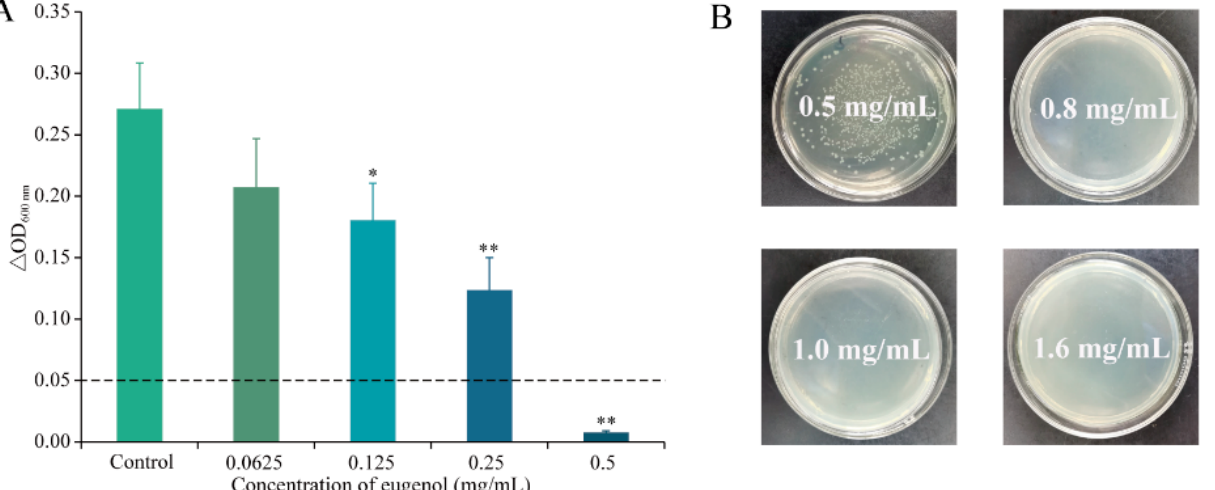
Figure 1. The MIC ( A ) and MBC ( B ) of eugenol against Sh. flexneri ATCC 12022. * indicates statistical significance of p < 0.05 compared with the control, ** indicates statistical significance of p < 0.01 compared with the control.